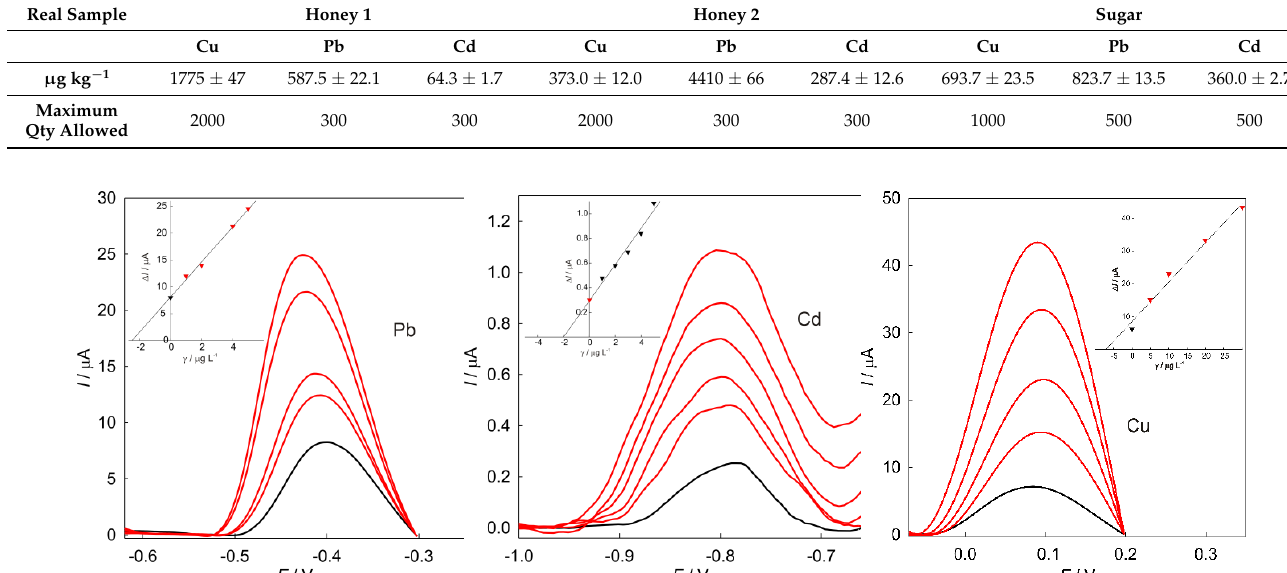
Table 3. Obtained concentrations of Cu, Pb, and Cd in sweeteners (honey and sugar).